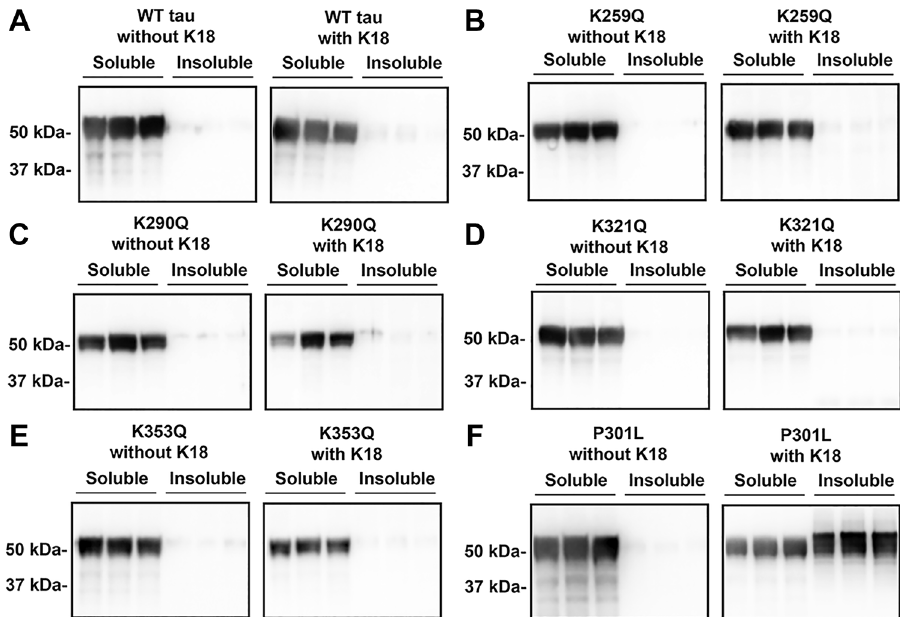
Figure 3. Pseudoacetylation at KXGS motifs do not lead to significant aggregation even with K18 seeds. HEK293T cells were transfected with 0N4R WT tau and 0N4R tau acetylmimetics K259Q, K290Q, K321Q, and K353Q. Cell lysates were fractionated into Triton soluble and insoluble fractions to isolate potential tau aggregates. Immunoblots were probed with tau antibody 3026. ( A ) WT tau does not aggregate with or without K18 seeds. ( B ) K259Q, ( C ) K290Q, ( D ) K321Q, and ( E ) K353Q 0N4R tau are also resistant to aggregation with or without K18 seeding. ( F ) P301L 0N4R tau was used as a positive control. The relative molecular weight markers are shown on the left.